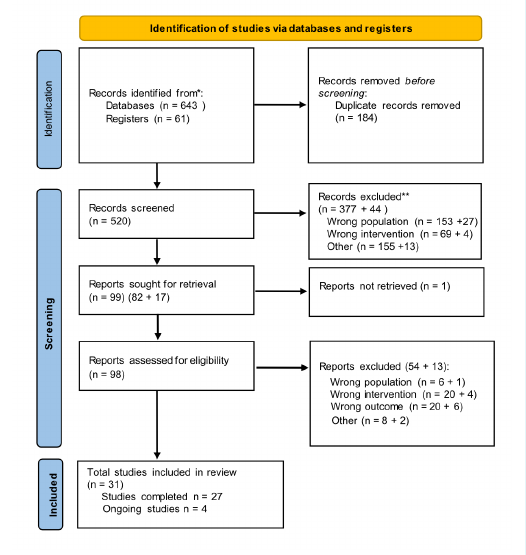
Figure 1: PRISMA flow diagram, adapted from http://www.prisma-